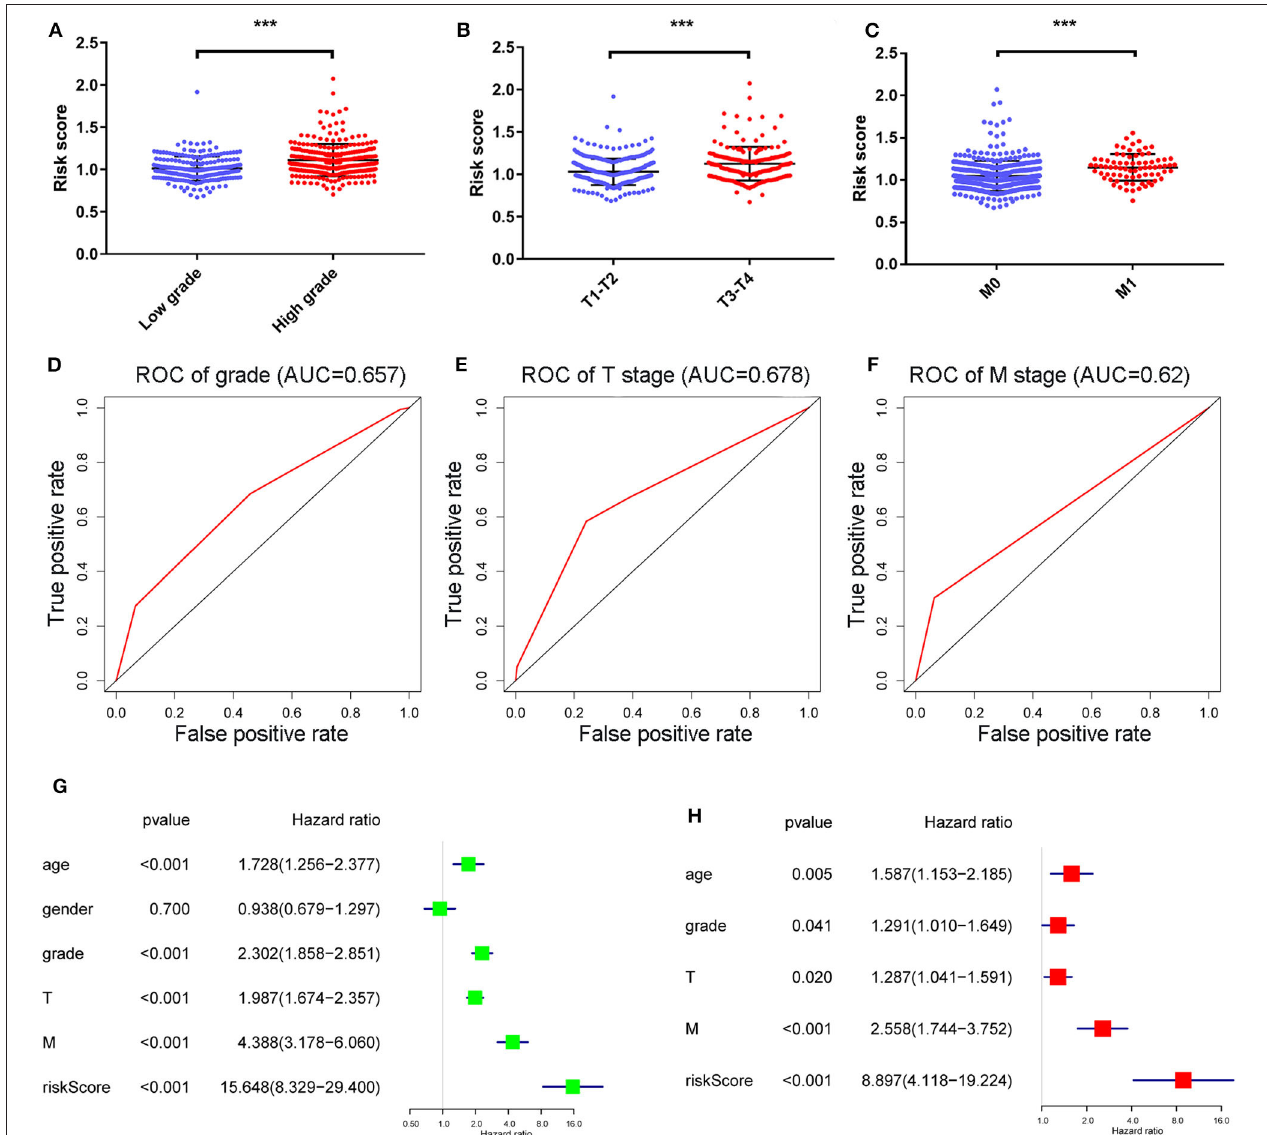
FIGURE 4 | The distribution of RS in ccRCC patients with high and low grades, T stage and M stage (A–C) and their correlated 5-year survival ROC curves (D–F) . ***Means p < 0.01. Univariate and multivariate cox analyses of the RS model and other clinicopathological characteristics with overall survival (G,H) .